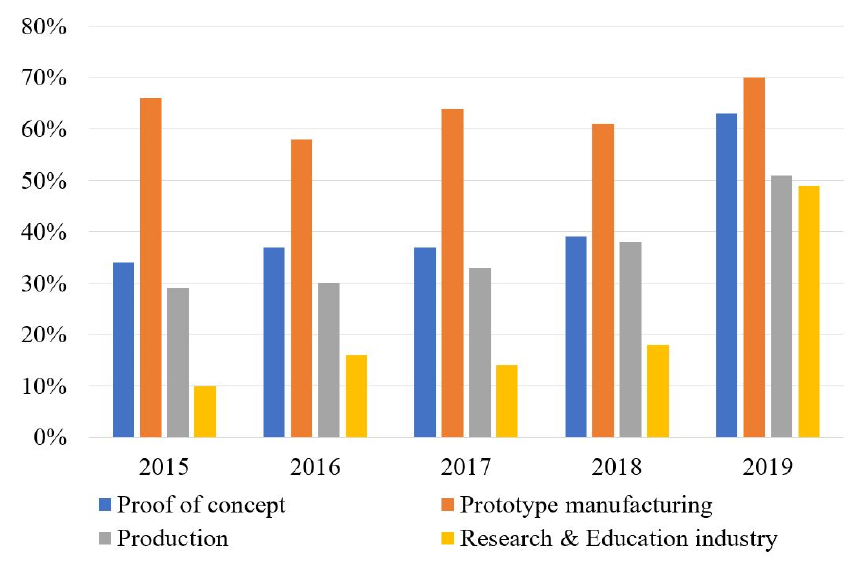
Figure 1. The percentage distribution of additive manufacturing (AM) from 2015 to 2019 in prototype manufacturing, production, the research and education industry and mechanical part manufacturing [1].